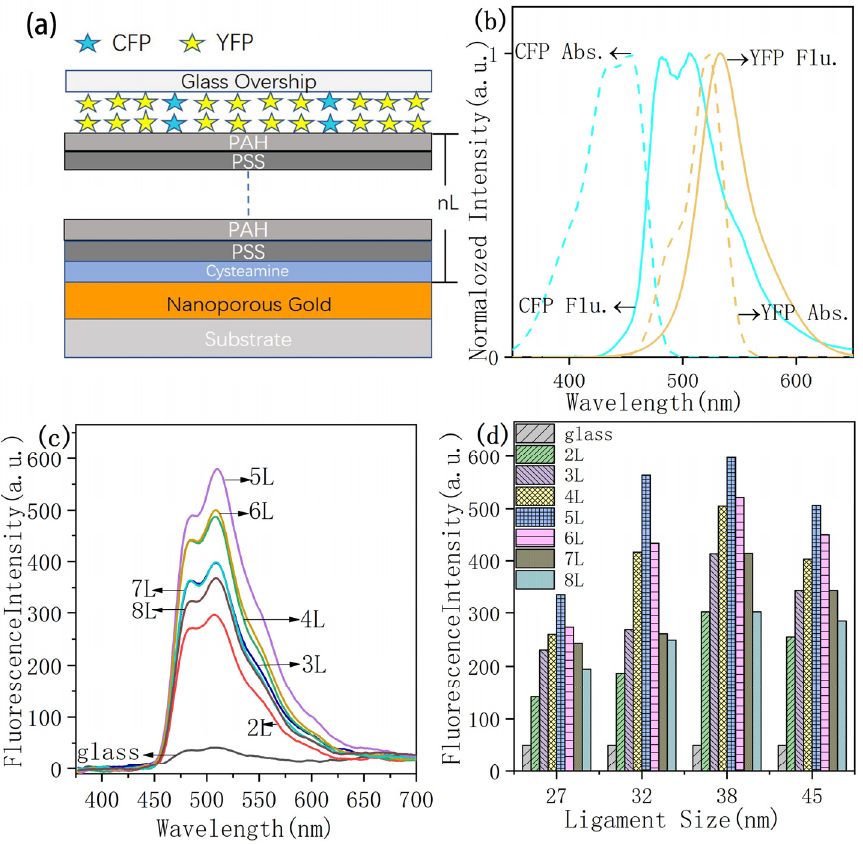
Figure 2. Scheme and spectrum. ( a ) Scheme of donor–acceptor assemble on the surface of glass and NPG. ( b ) Normalized absorption and fluorescence spectra of donor and acceptor for CFP and YFP. ( c ) Fluorescence spectra of donor (CFP) at 2–8 L to NPG films with NPG Ligament diameter of 38 nm. The black carve is the emission spectrum of CFP on glass slide. ( d ) The average peak value of CFP fluorescence intensity at 2–8 L to NPG films with NPG Ligament of 27 nm, 32 nm, 38 nm, and 45 nm.